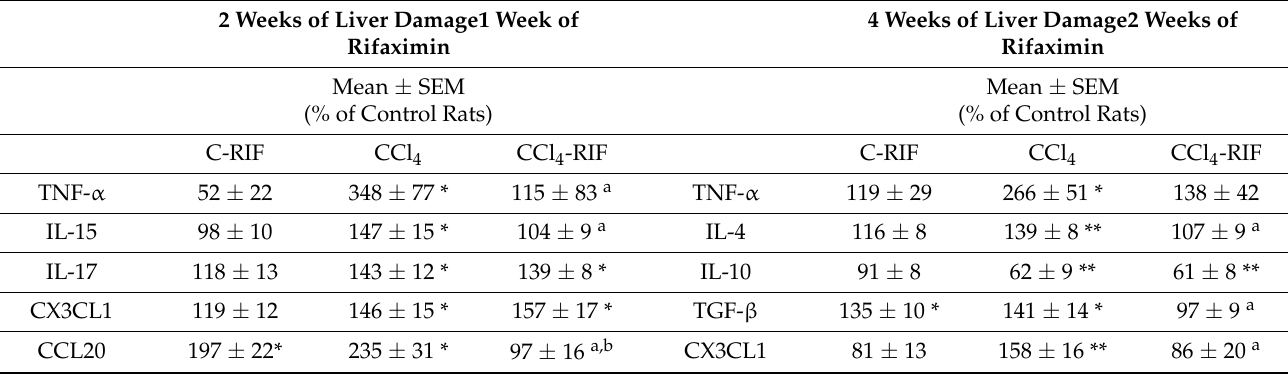
Table 4. Effects of treatment with rifaximin on the changes in plasma cytokines at 2 and 4 weeks of liver